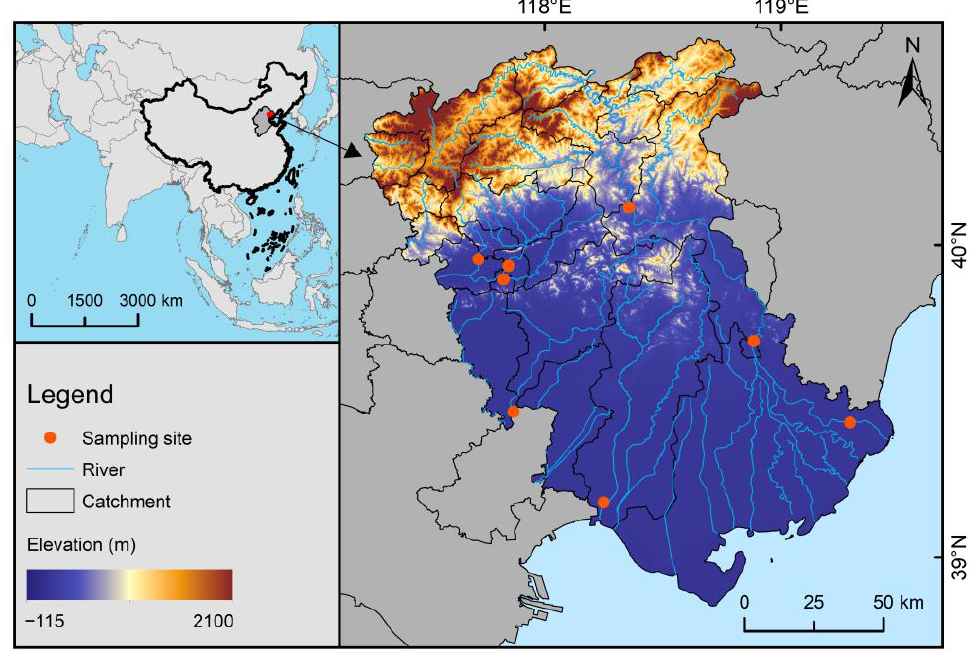
Figure 1. The geographical location of the study region. In the map showing the national boundaries, the dark grey area is the Haihe River basin in China and the red dotted area is the study area.